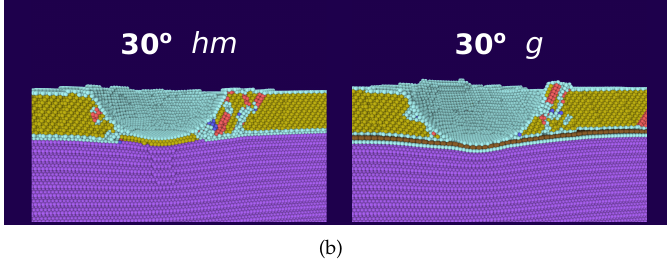
Figure 10. Comparison of the indentation into a Ni bi-crystal with a 30 ◦ twist boundary without hm and with g graphene. ( a ) averaged force–depth curves; ( b ) snapshots showing the microstructure immediately before dislocation nucleation in the lower Ni block: at d = 3.4 nm ( hm ) and at d = 4.0 nm ( g ). Atoms are colored as in Figure